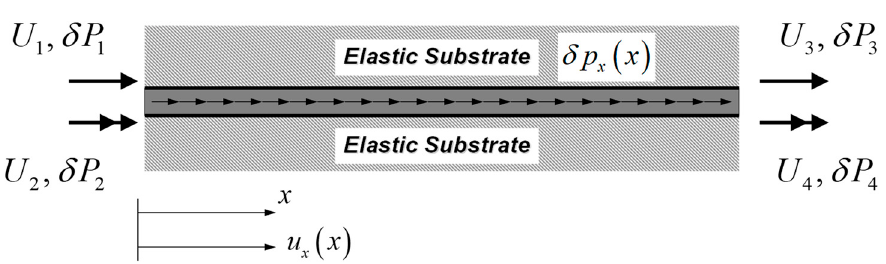
Figure 3. Nanobar-elastic substrate system: the virtual-force formulation. Enforcing the compliance-type constitutive relations of Equations (20) and (22),